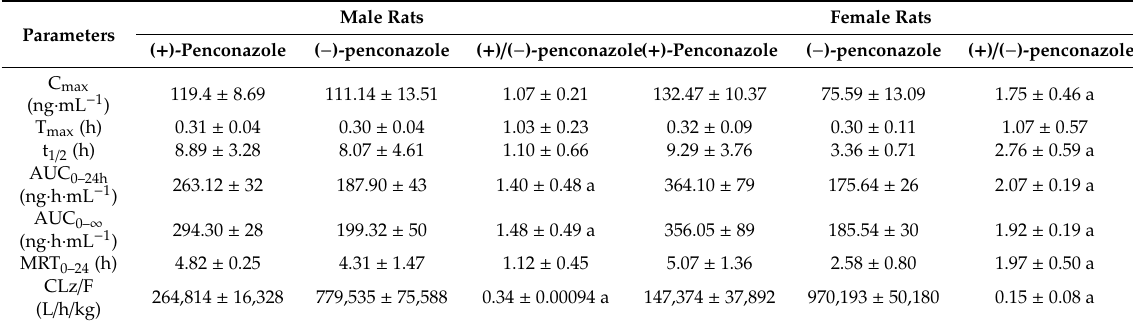
Figure 3. Plasma concentration–time curves obtained after a single oral administration of 50 mg · kg − 1 penconazole to Sprague–Dawley rats: ( A ) Adult female; ( B ) adult male. Table 4. Toxicokinetic parameters (mean ± SD) of penconazole enantiomers in Sprague–Dawley rats ( n = 6) following single oral administration at a dose of 50 mg kg − 1